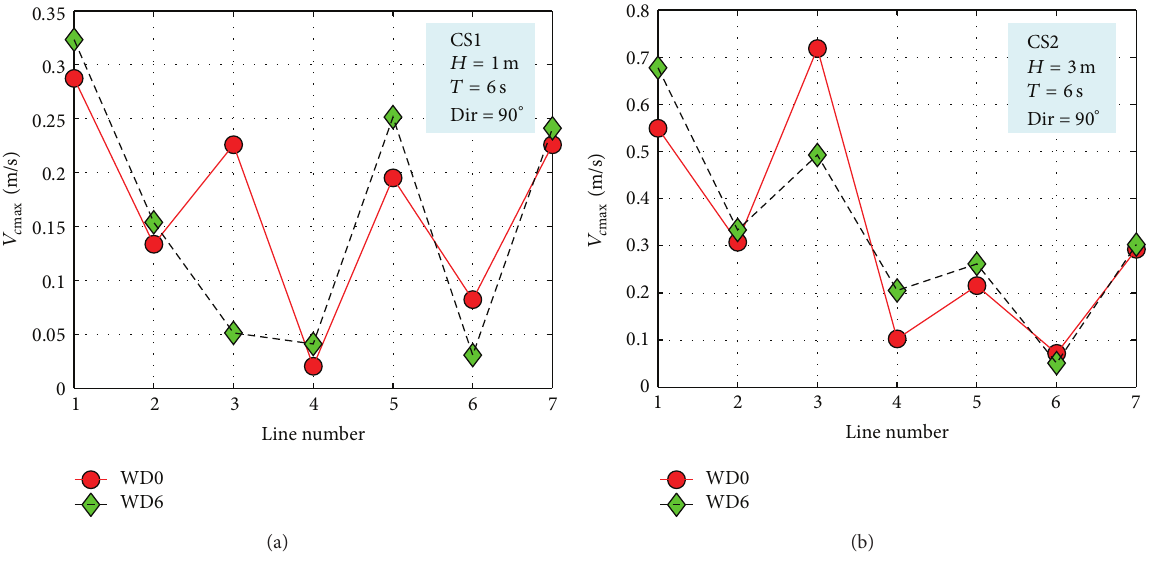
Figure 10: Evaluation of the impact of the energy farms on the maximum velocities of the nearshore currents along the reference lines considered. (a) CS1, (b) CS2. Table 4: Evaluation of the impact of the energy farms on the waves in the reference points OP1, OP2, and OP3 for the wave conditions (a) ∘ and (b) 𝐻 ∘ 𝑇 𝑇 𝐻 𝑠 = 1m, 𝑚 = 4s, and Dir = 30 𝑠 = 1m, 𝑚 = 4s, and Dir = 150